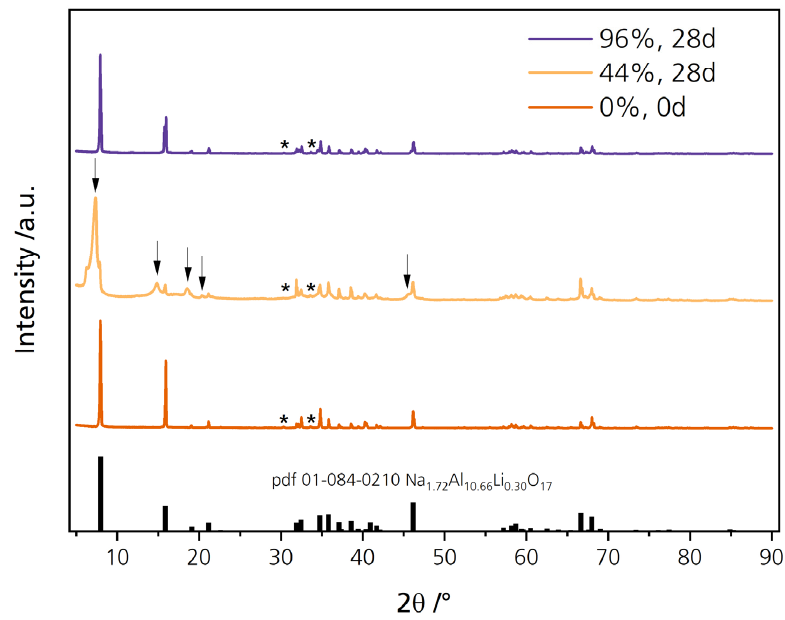
Figure 5. Diffraction patterns of the pristine disk and the disks stored for 28 days in 44% r.h. and 96% r.h. The reflections, highlighted with asterisks, can be related to NaAlO 2 . The diffraction pattern of the sample stored in 44% r.h. for 28 days also agrees with